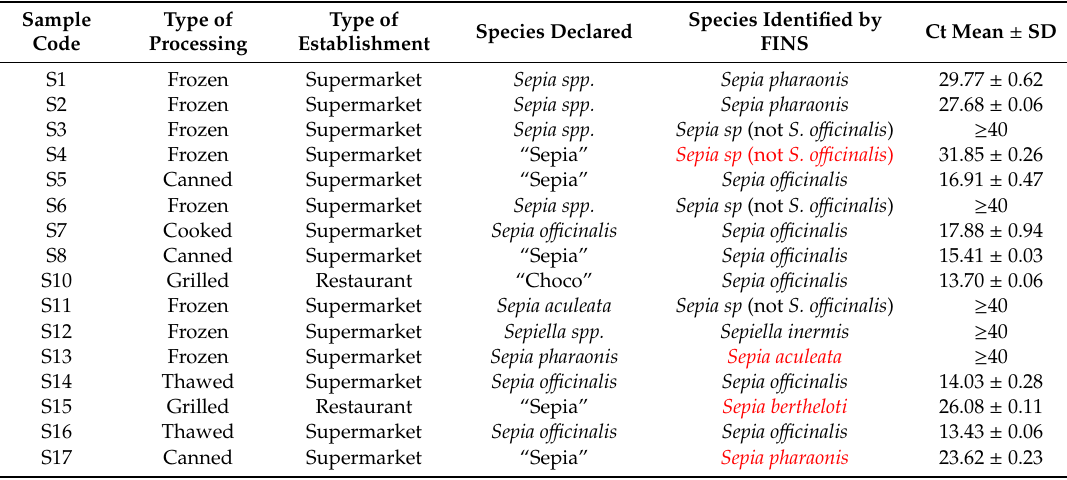
FAO: Food and Agriculture Organization. SD: Standard Deviation. Table 2. Commercial samples used for validation. The mislabeled samples are highlighted in